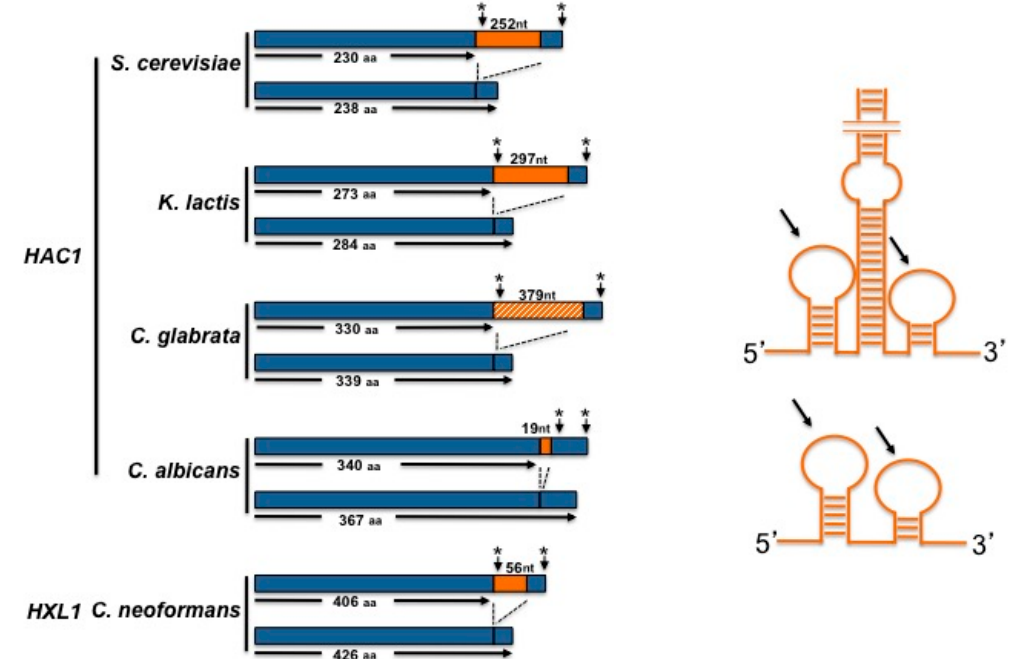
Figure 3. ( Left ) Scheme of un-spliced and spliced HAC1 (or HXL1 ) RNAs. Sizes of putative protein products from un-spliced and spliced RNAs are depicted. Introns (and their sizes in nucleotides) are shown by the orange boxes. The putative HAC1 intron of C. glabrata , that appears not to be processed is indicated by the slashed box. Stop codons are indicated by asterisk. ( Right ) Scheme of putative stem-loop structures of large and small introns. Arrows indicate 5 ′ and 3 ′ exon-intron boundaries. Structures are not drawn to scale.